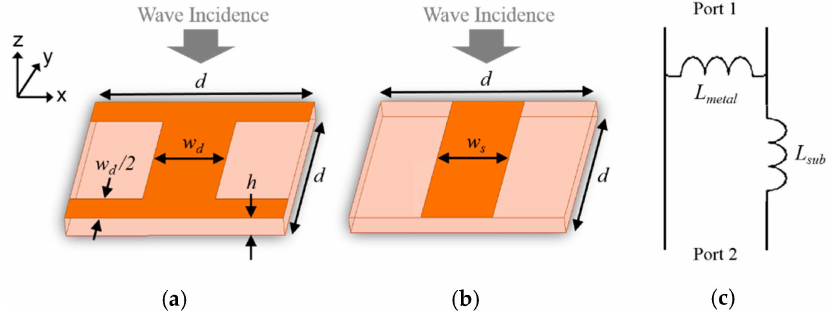
Figure 2. ( a ) Conventional dual-pol grid, ( b ) proposed single-pol grid, and ( c ) equivalent circuit of the grid.